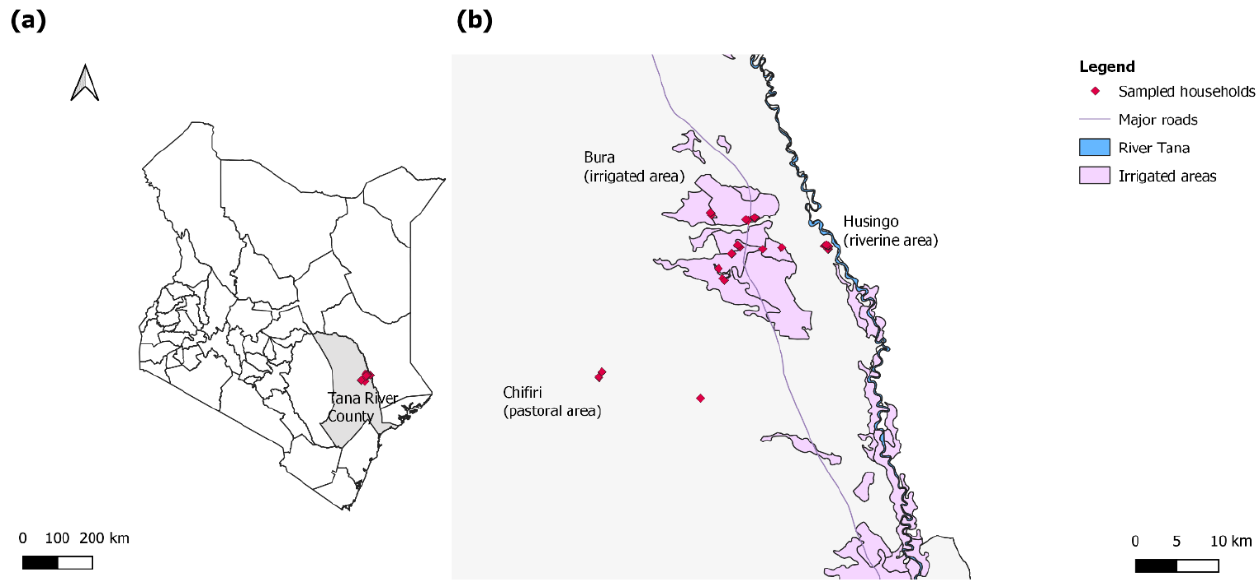
Figure 1. ( a ) A map of Kenya highlighting Tana River County in gray and the study sites in red; ( b ) a map highlighting the households sampled in the three sites (red). The sites included the pastoral Chifiri village, the riverine Husingo village, and the settlements in the Bura irrigation scheme.